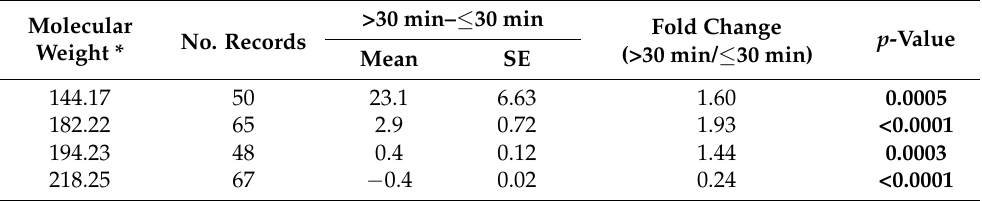
Table 3. Duration of exposure comparison of hydroxylated PAH (OHPAH) collected from urine samples (unit: ng/g—creatinine) by molecular weight. Bold p -value indicates a statistically significant difference in urinary OHPAH levels by time spent at fire activity. Molecular No. Records Weight *